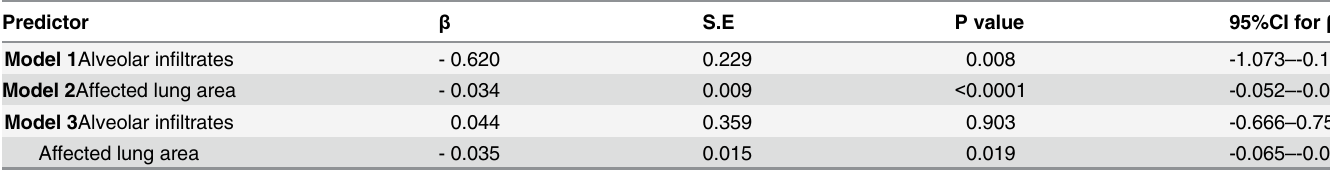
Table 5. Univariable linear regression: association of affected lung area with BMI Predictor